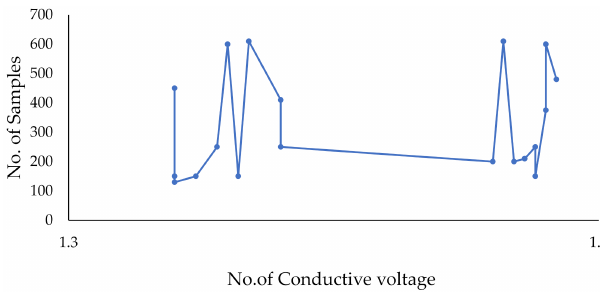
Figure 9. Graph of the fourth case with two